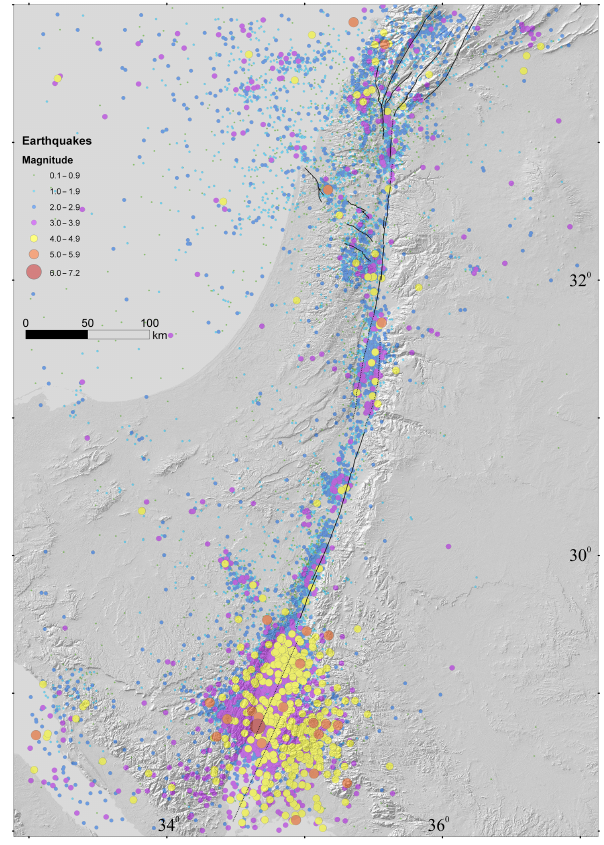
Figure 2. Epicentres in Israel and surrounding areas between the years 1983 and 2017, based on the relocated earthquake catalogue. Circle size and colours indicate the magnitude. Black lines repre- sent the main fault segments of the DST and the CTF. The shaded relief background of this figure and the following ones is based on a digital elevation model of Earth (Farr et al.,